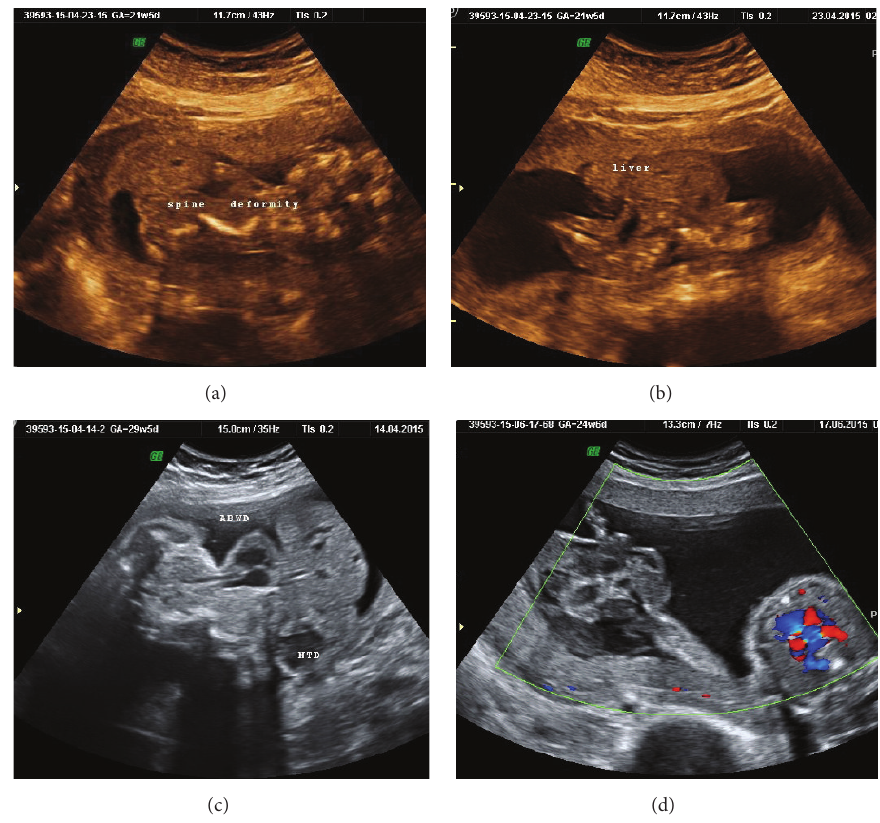
Figure 6: (a, b, and c) show gross fetal deformity limb body wall complex, diagnosis delayed till 21 weeks in one fetus (Figures 6(a) and 6(b)) and 29 weeks in other fetuses (Figure 6(c)). (d) shows acardiac twin (twin reverse arterial perfusion sequence) diagnosed at 25 weeks when the normal twin had already decompensated making any intervention